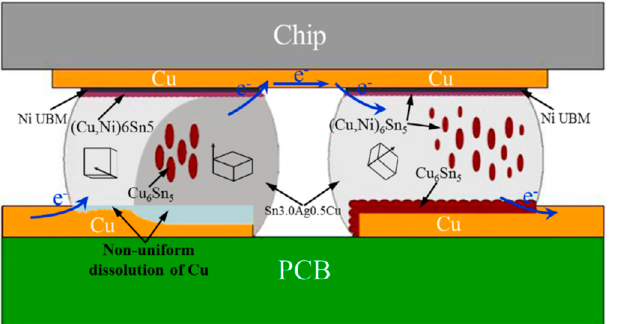
Figure 13. Schematic diagrams of EM behavior in Ni/Sn-3.0Ag-0.5Cu/Cu flip-chip solder joint Reprinted with permission from Ref. [60] Copyright 2015 Elsevier.